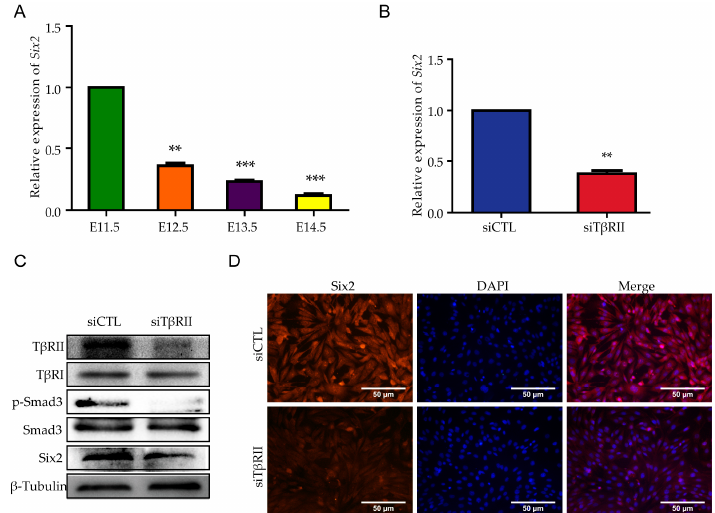
Figure 2. T β RII increases the expression of Six2 in mK3 cells. ( A ) The expression pattern of Six2 at mRNA level of embryo kidney from E11.5 to E14.5; ( B ) The mRNA level of Six2 in mK3 cells after the treatment of siT β RII; ( C ) The protein level of Six2, p-Smad3, Smad3, and T β RI in mK3 cells after the treatment of siT β RII; ( D ) The immunofluorescence of Six2 after the treatment of siT β RII. All data are displayed as means ± SD from three independent experiments, ** p < 0.01, *** p < 0.001.